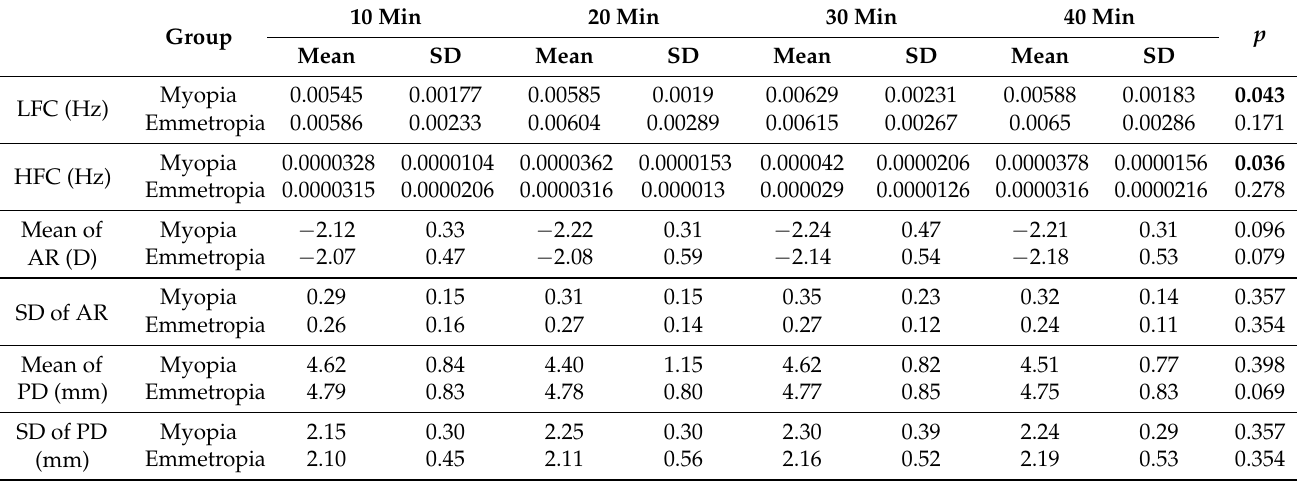
Figure 1. The baseline value of the low-frequency component (LFC) is lowest during the near work test. The LFC of myopia group gradually increases with time, reaching a peak at 30 min before a gradual decline. The low-frequency component of myopic individuals was significantly different between the baseline and the periods of sustained near work of 10, 20, 30, and 40 min, as revealed by one-way repeated measures ANOVA ( p < 0.05). Table 2. Descriptive statistics measured at baseline and after 10, 20, 30, and 40 min of sustained near work for two refractive groups.